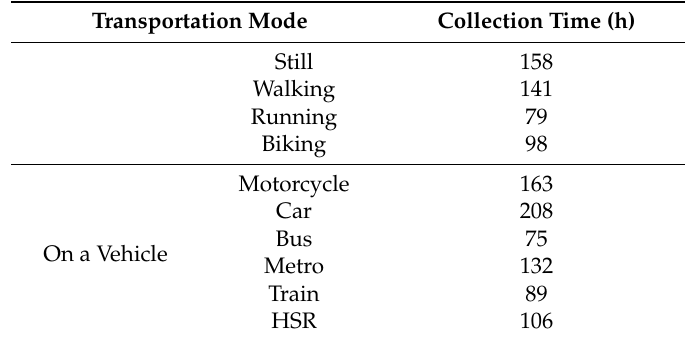
Table 1. Database description based on Reference [5].